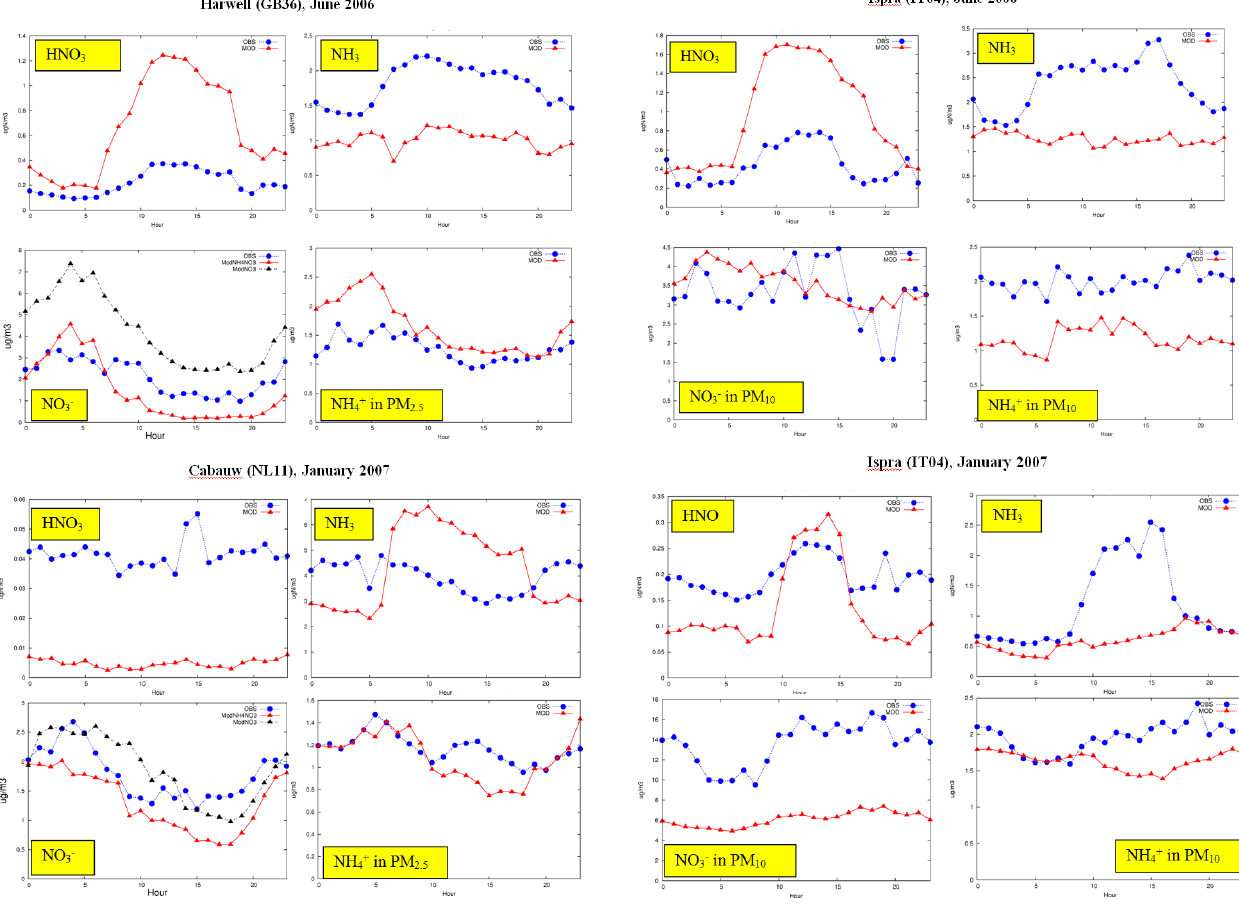
Fig. 8. Diurnal variations of gaseous and particulate nitrogen species from some of the intensive measurements compared with the EMEP model. Measured ammonium and nitrate in PM 2 . 5 at Cabauw (NL11) and Harwell (GB36) while in PM 10 at Ispra (IT04) Note: there are two curves showing model results of nitrate at Cabauw and Harwell: for ammonium nitrate (NH 4 NO 3 ) (red) and nitrate in PM 10 , (mod NO3) which is the sum of NH 4 NO 3 and coarse NO − (black) (see explanations in Sect. 3.2.1). 3